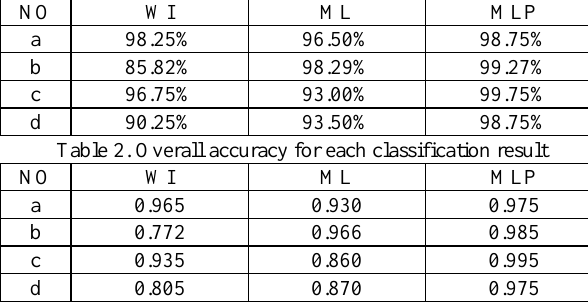
Table 3. Kappa coefficients for each classification